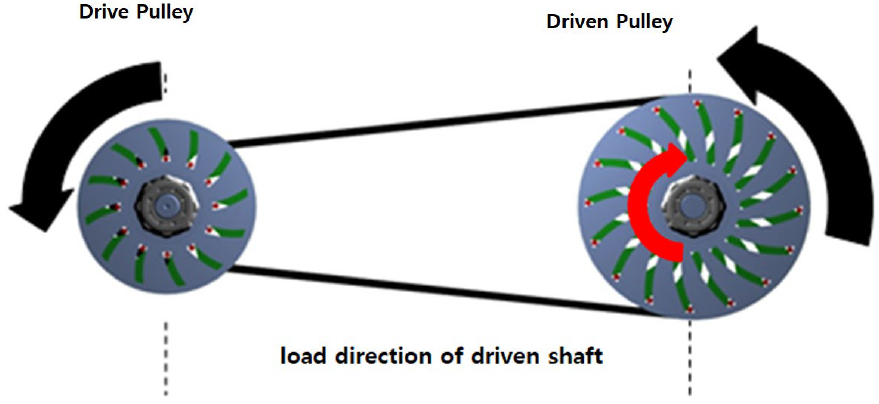
Figure 3. Deceleration principle of the centrifugal belt pulley CVT.